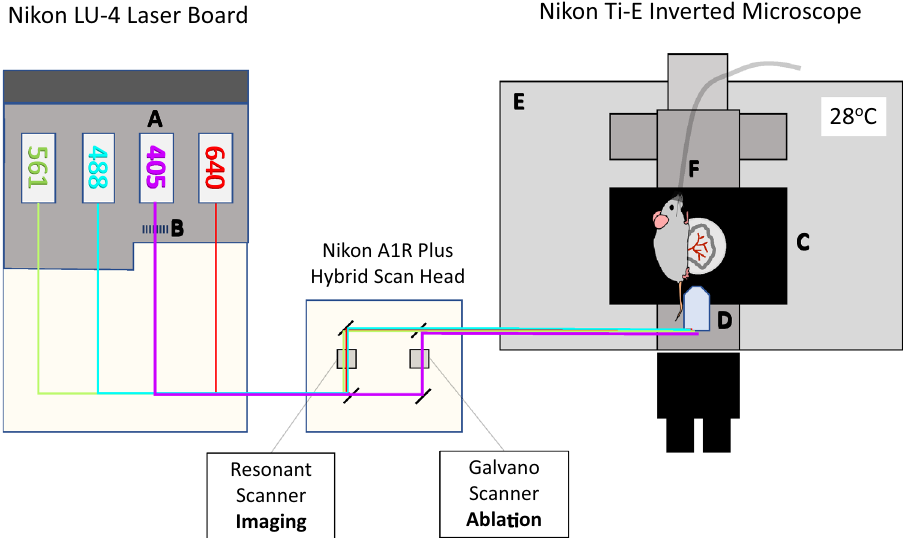
Figure 1. Schematic drawing showing the imaging platform used for the scanning-LIEI model. A standard Nikon A1R-plus dual scanner system was customised for live animal imaging and vessel ablation by the following modifications: The laser board was equipped with a 200 mW 405 nm CW solid-state laser ( A ) and the laser path was modified with an ND32 neutral density filter in a manual slider ( B ) allowing the 405 nm laser beam to be used at full power for laser ablation or attenuated for imaging. The system was further equipped with a Mad City labs Z-axis Piezo nanopositioner stage ( C ) for rapid imaging in the Z-dimension. The microscope was fitted with a Nikon CFI75 Apochromat 25XC W lens ( D ) with a high numerical aperture of 1.10, a long working distance of 2.0 mm and an adjustable ring to correct for depth-dependent spherical